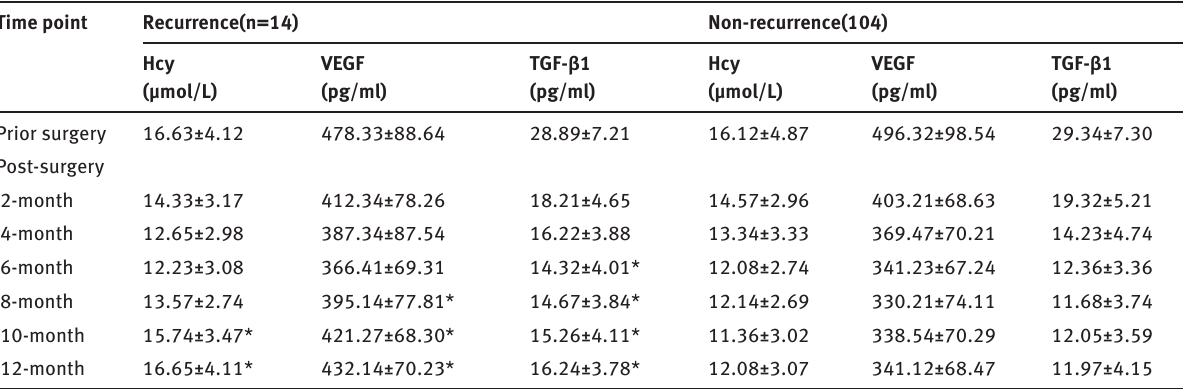
Table 3: The serum Hcy, VEGF and TGF-β1 dynamic change in colorectal cancer patients.